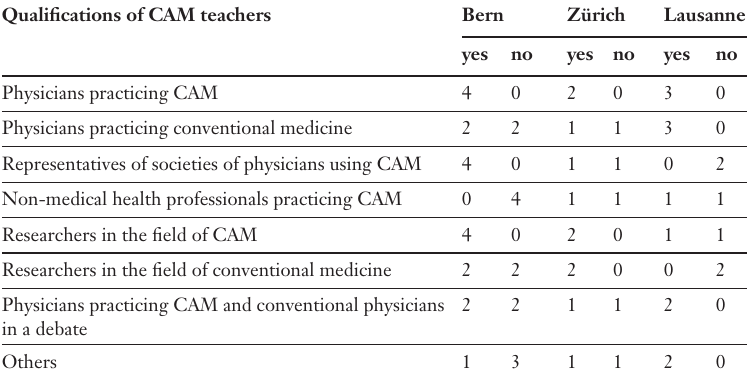
Qualifications of CAM teachers.